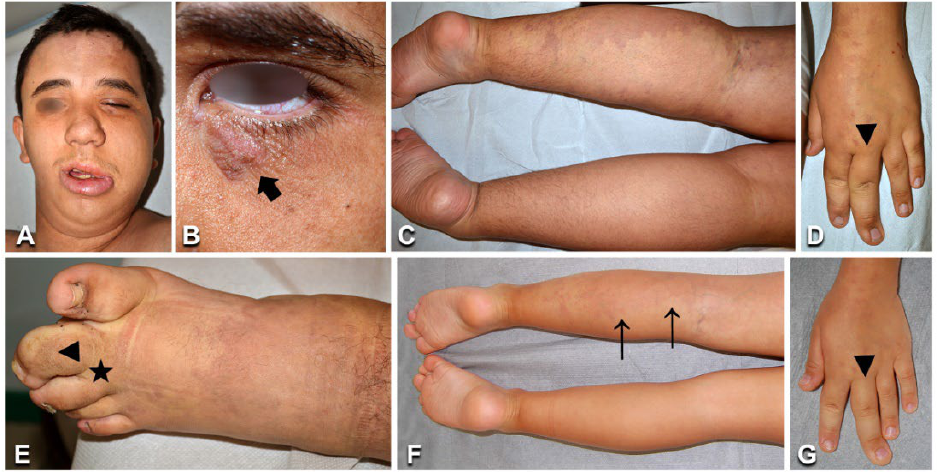
Figure 5. Clinical and imaging features in a young patient with megalencephaly–capillary malformation–polymicrogyria syndrome. Patient n. 28 presents a diffuse, partly reticulate capillary malformation ( A , C–E , arrows in F , G ), macrocephaly and left face hypertrophy ( A ), and an epidermal nevus on the left lower eyelid ( B , arrow). Hand and foot anomalies include left third finger macrodactyly (arrowhead in D , G ), left second toe macrodactyly, and proximal syndactyly of toes 2–3 (arrowhead and asterisk in E ). The progressive overgrowth is documented in panels ( F , G ) versus panels ( C , D ), showing pictures taken at 6 and 19 years,